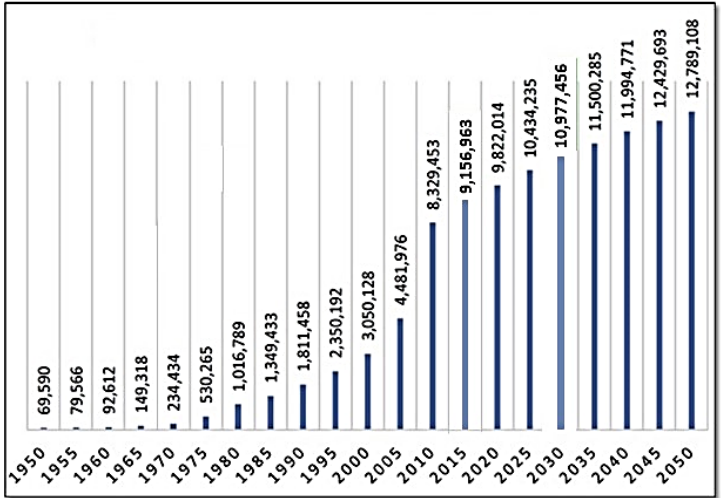
Figure 1. Population status by year in UAE. Reprinted from Ref. [18] with permission from Elsevier (Copyright 2018).